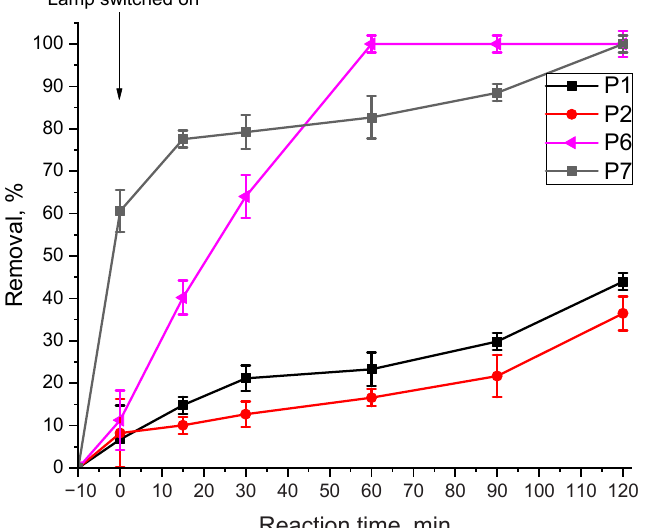
Figure 8. Example of removal of amoxicillin from water solution using a solar simulator as an irradiation source.